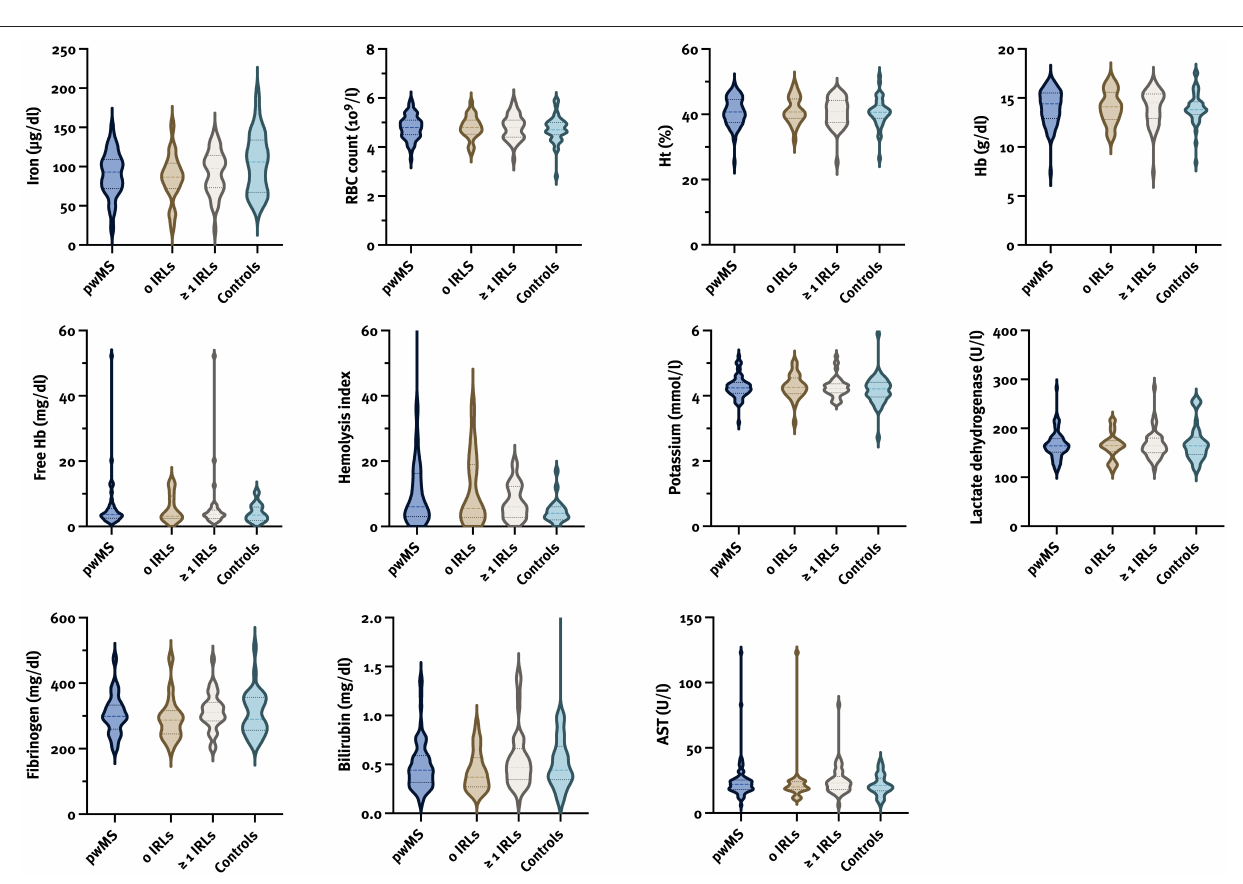
p = 0.011 and β = 0.33; 95% CI 3.29, 28.95; p = 0.015;